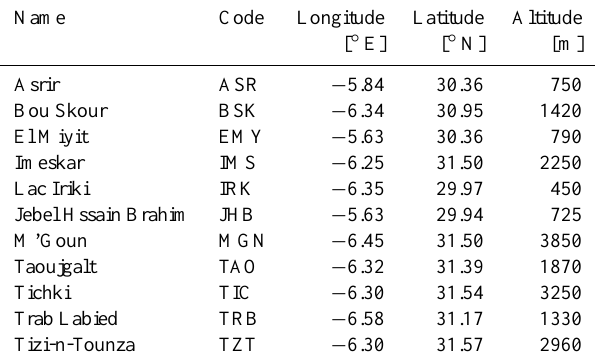
Table 1. Detailed information of the eleven IMPETUS test sites.